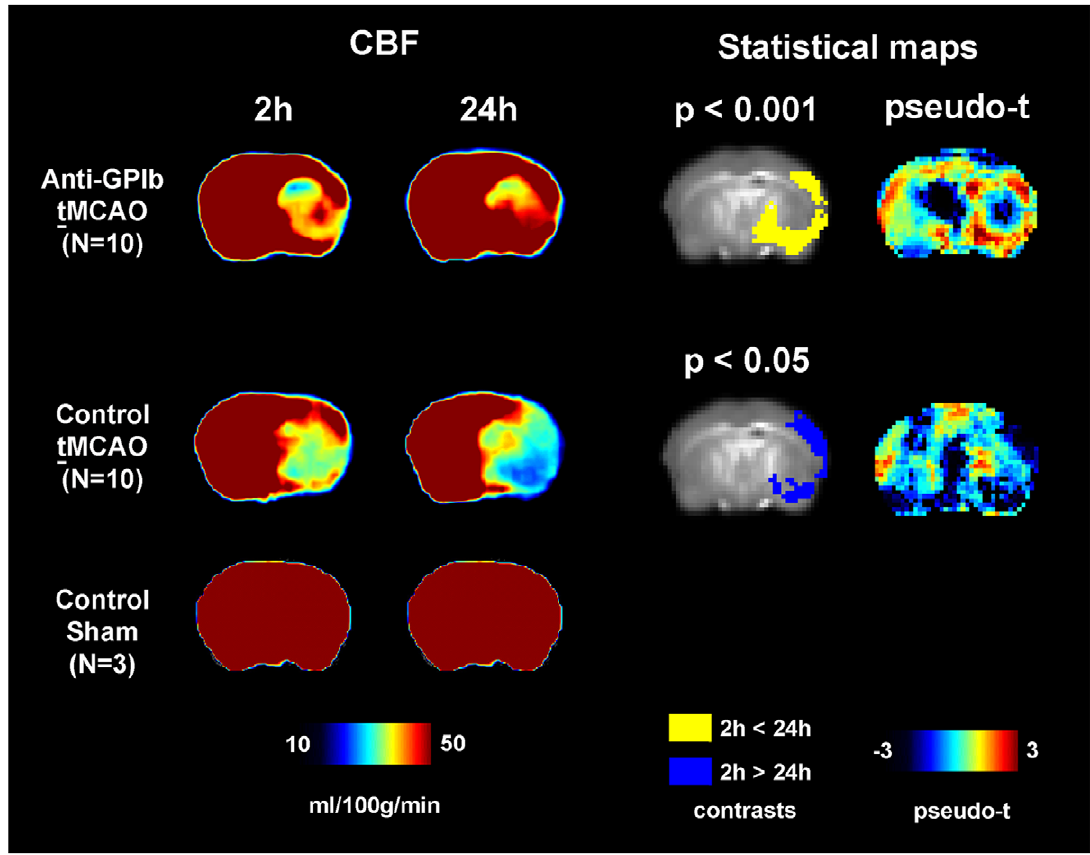
Figure 1. CBF and statistical maps of voxel-wise group comparisons. Sustained reperfusion is demonstrated by significantly elevated cortical perfusion in anti-GPIb treated mice as compared to persisting severe hypoperfusion in control mice. Color maps of mean CBF are given for each group and time point (left, CBF). The results of voxel-wise statistical analyses of change in CBF over time are shown on the statistical parameter maps (right, Statistical maps). The spatial distribution of significant reperfusion in the anti-GPIb treated group is indicated by the yellow overlay (yellow contrast of 24 h . 2 h). The spatial distribution of significant deterioration of hypoperfusion in control mice after t MCAO is indicated by blue overlay (blue contrast of 2 h . 24 h). doi:10.1371/journal.pone.0018386.g001 PLoS ONE |